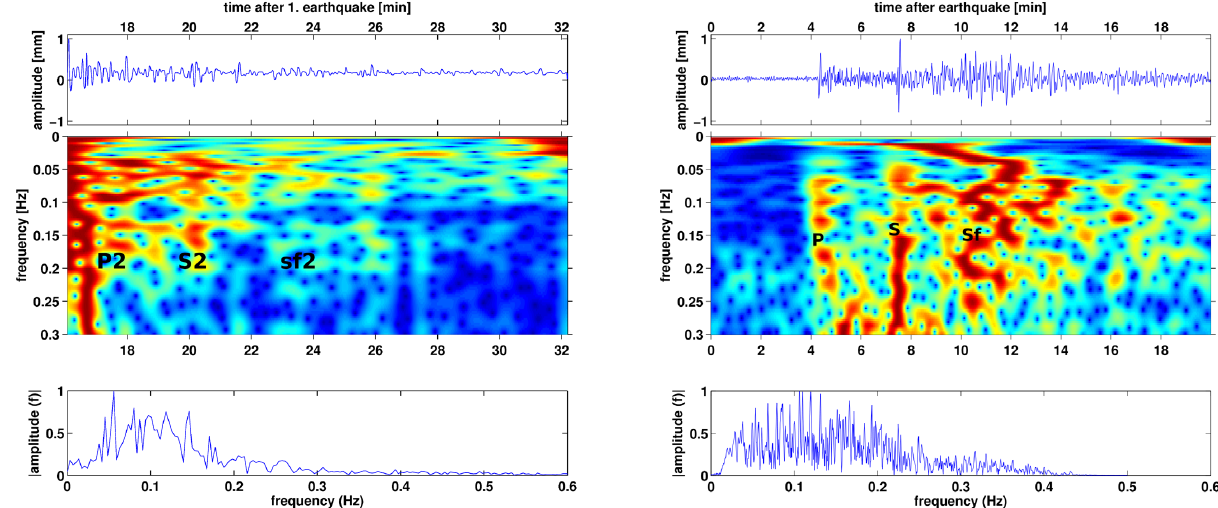
Figure 16. Left: multiple filter technique (MFT) time–frequency spectrum for the second Amorgos event computed from vertical component data of historic station GTT. Right: for comparison, MFT time–frequency spectrum for a modern intermediate-depth event near the island of Milos computed from vertical component data of station MOX of the German Regional Seismic Network (GRSN). In each subfigure, the top panel shows the data trace, the central panel displays the time–frequency spectrum and the bottom panel shows the amplitude spectrum of the